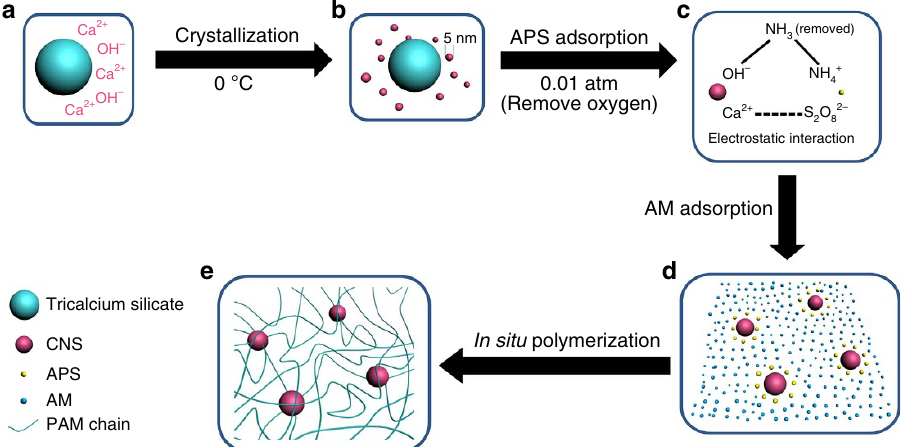
Figure 3 | Schematic diagram of PAM crosslinked with the CNS released from tricalcium silicate (Ca 3 SiO 5 ). ( a ) Ca 2 þ and OH (cid:2) released from the surface of a Ca 3 SiO 5 particle during the hydration process. ( b ) CNS with diameters o 5nm formed from the crystallization of calcium hydroxide at 0 (cid:2) C. ( c ) S 2 O 8 2 (cid:2) from the initiator APS adsorbed on the surfaces of CNS via electrostatic interaction prompted by low pressure (0.01atm). ( d ) Introduction of the monomer acrylamide (AM). ( e ) In situ polymerization of PAM on the surfaces of